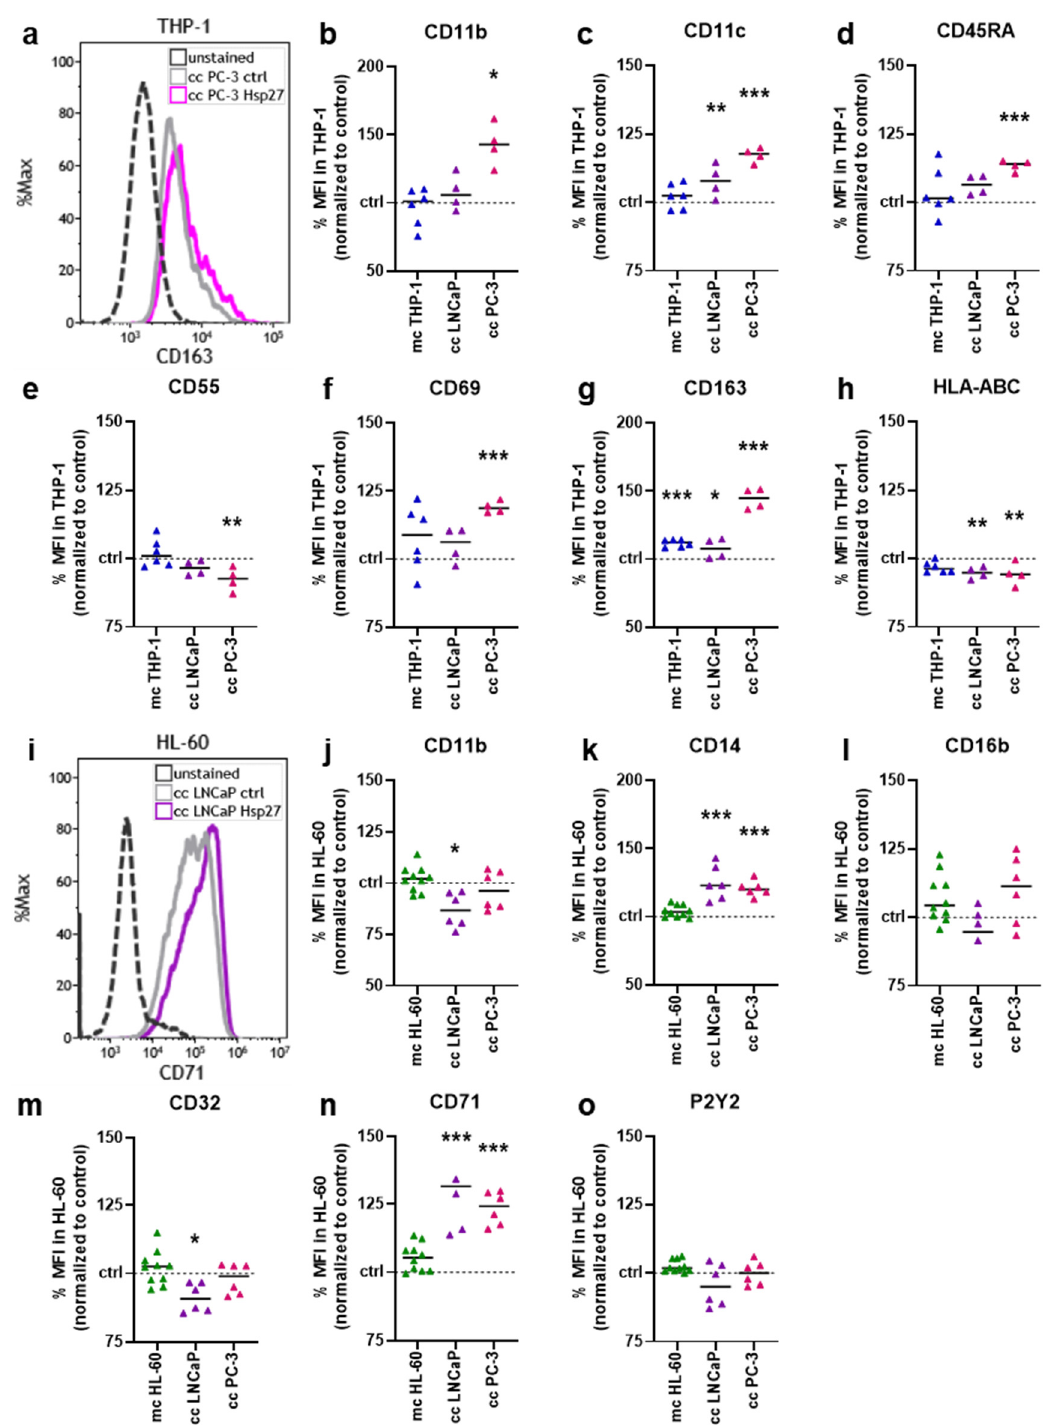
Figure 3. Hsp27-modified surface marker expression on myeloid–prostate cancer cell